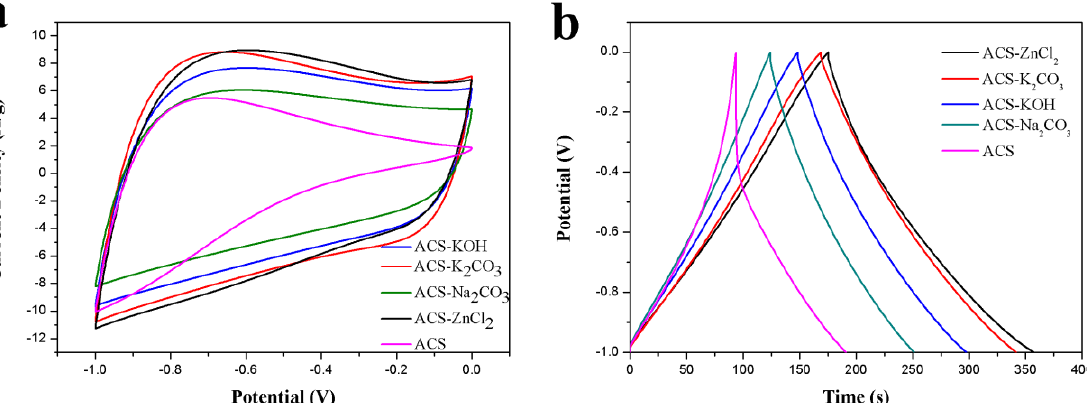
Figure 4. ( a ) CV curves (50 mV/s) and ( b ) GCD curves (1 A/g) of ACS, ACS-Na 2 CO 3 , ACS-KOH, ACS-K 2 CO 3 , and ACS-ZnCl 2 in 6 M KOH in three-electrode system.